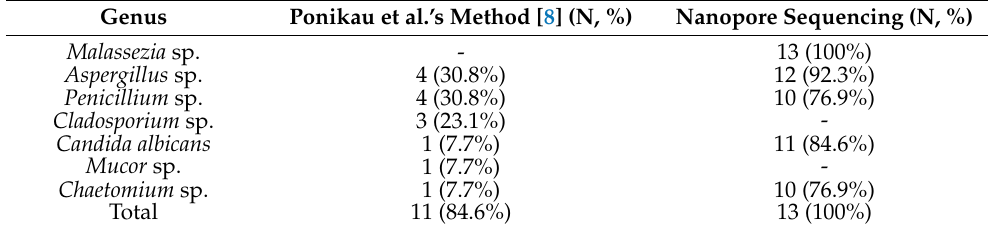
Table 4. Comparison of the genus level of fungi between Ponikau et al.’s method [8] and nanopore sequencing.